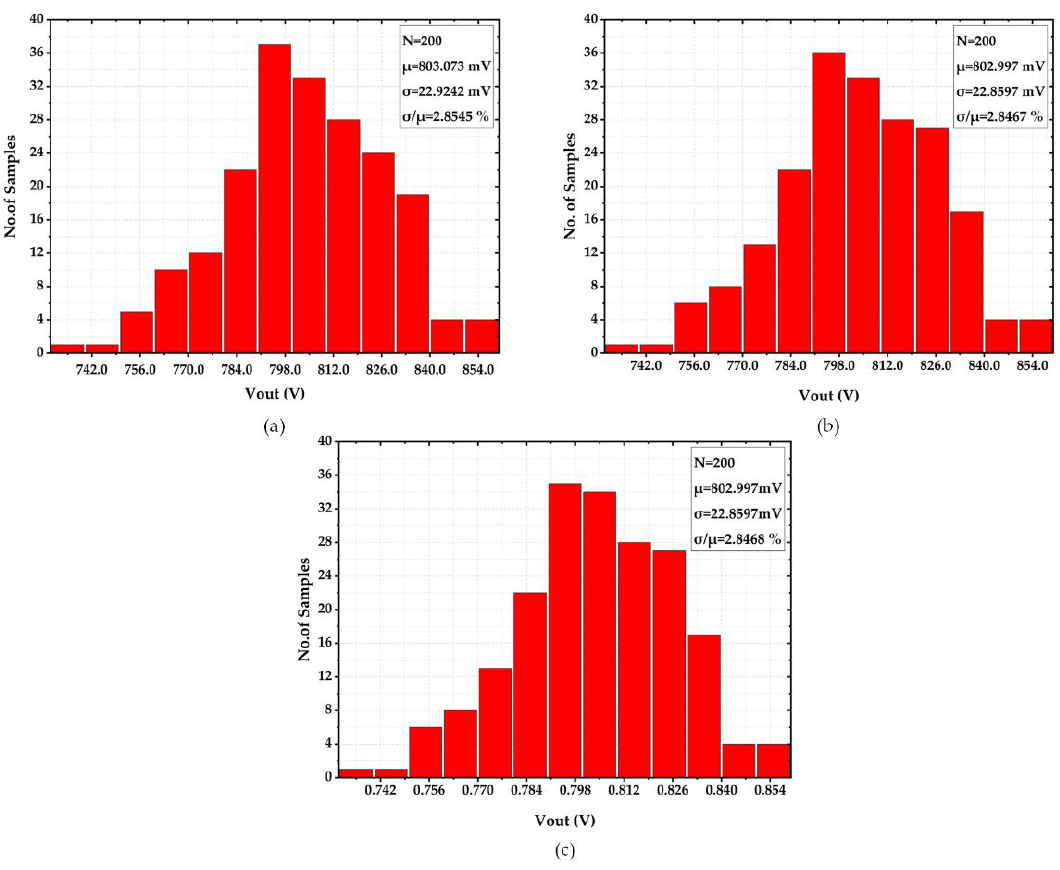
Figure 12. Monte-Carlo Simulation of Process Sensitivity ( a ) at −4 0 ℃ ( b ) at 27 ℃ ( c ) at 90 ℃.